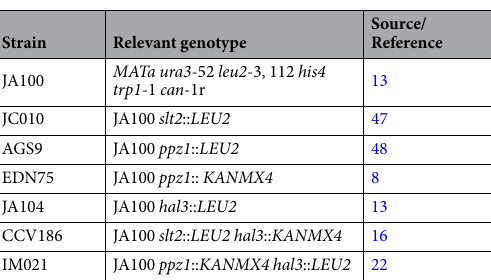
Strain Relevant genotype JA100